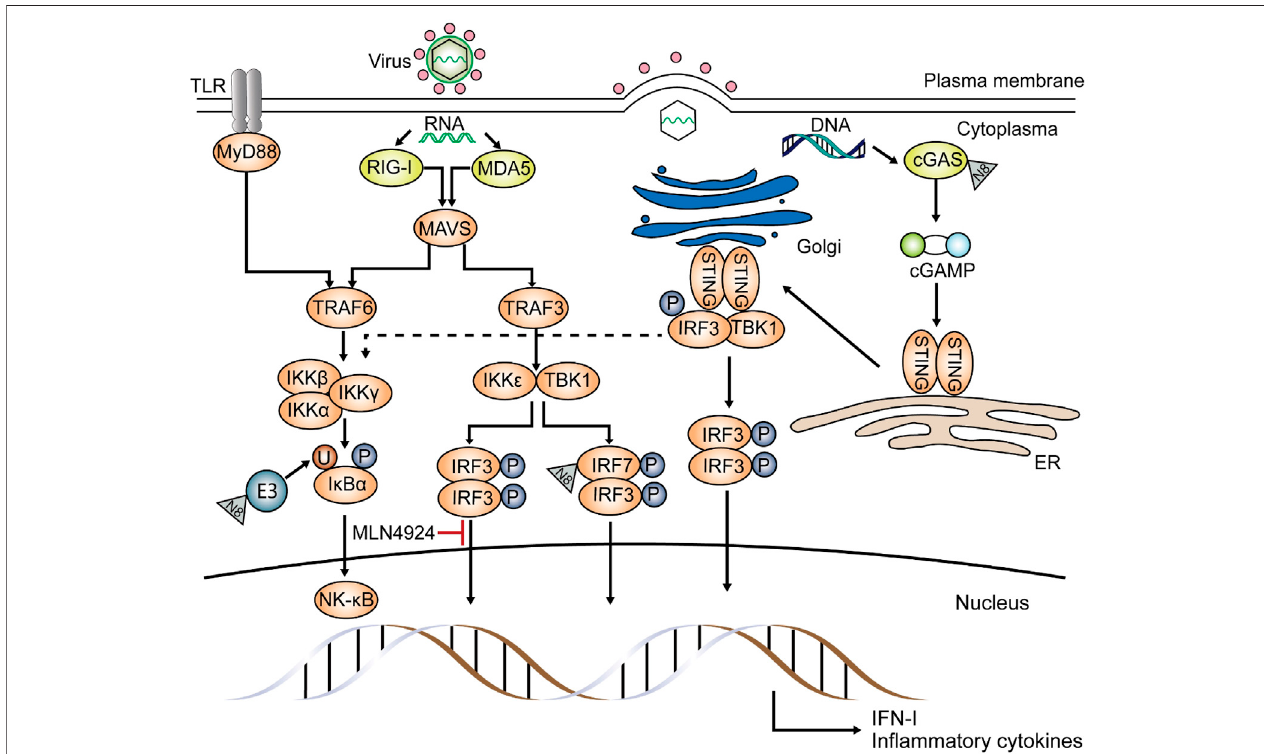
FIGURE 3 | Effects of neddylation on the anti-viral pathway. Neddylation is pivotal in the antiviral pathway, inducing in fl ammatory cytokines and type I-IFN. Upon infection by RNA viruses, such as Sendai virus (SeV), NEDD8 either acts on ubiquitin E3 ligase and affects NF- κ B translocation or binds to IRF7 directly and promotes in fl ammatory cytokineand typeIIFNproduction. Moreover,neddylationisinvolvedintheconjugationofinterferon regulatory factor3(IRF3)and theIFN- β promoter,and thiswasprovedusingMLN4924.IfinvadersareDNAviruses,suchasherpessimplexvirus,NEDD8targetstheDNAsensorcyclicGMP-AMPsynthase(cGAS)and convertsittocGAMP.cGAMPthenattachestothestimulatorofinterferongenes(STING)andactivatesTANK-bindingkinase1(TBK1)andIRF3,activatingthetypeI-IFN gene. STING signaling also results in the expression of in fl ammatory cytokines through the NF- κ B pathway (dashed line). Other proteins involved in the innate antiviral pathway have not yet been reported as substrates of